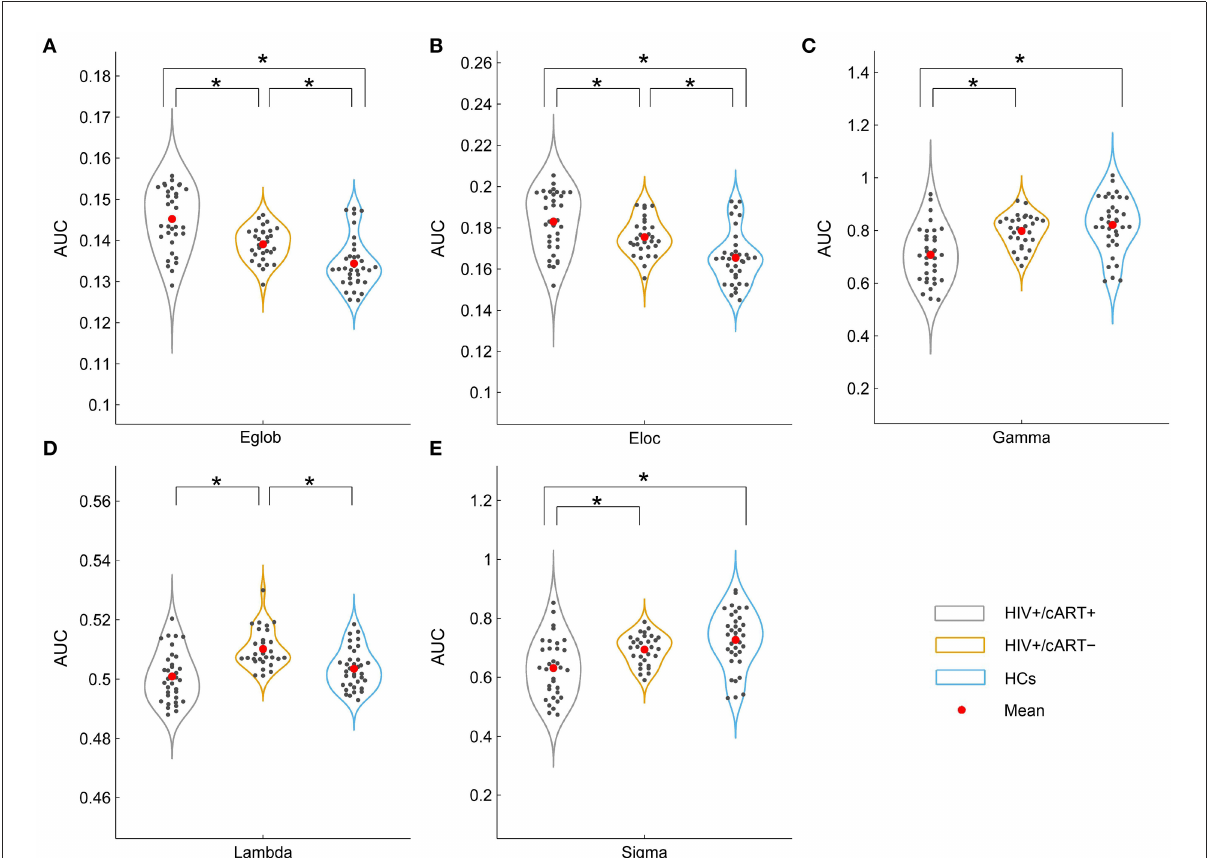
FIGURE4 Between-group results in large-scale metrics (A, B) and small-world properties (C–E) . The asterisks designate significant differences between the two groups. AUC, area under the curve; Eglob, global efficiency; Eloc, local efficiency; HCs, healthy controls; γ , normalized clustering coefficient; λ , normalized characteristic path length; σ , small-worldness; * p value <